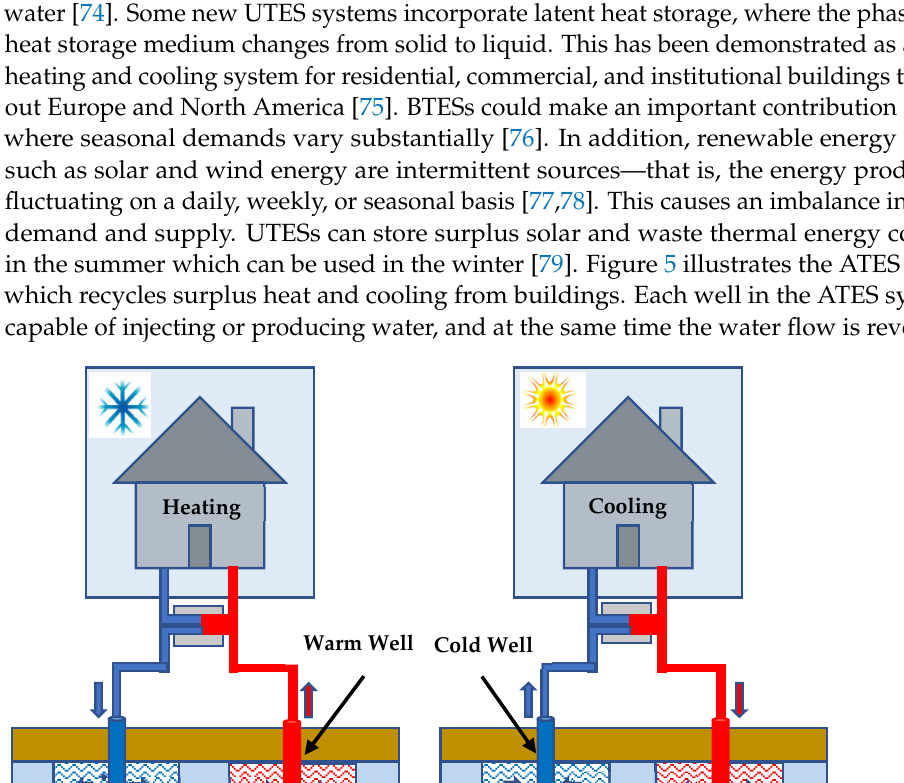
Figure 6. Schematic of Borehole Thermal Energy Storage (BTES and BHEs are connected in series).